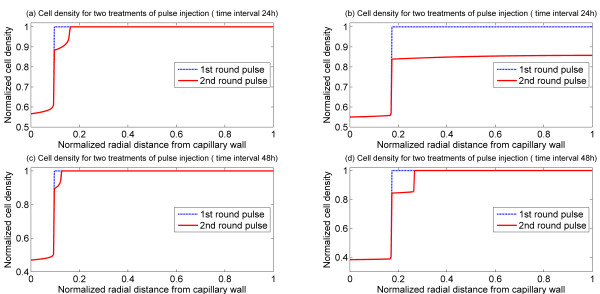
Spatial profiles of cell density for two rounds of pulse injection with the same pulse height and weight, S = 4, T = 1.5 h. Upper panel: cell density at 36 h with 24 h interval between pulses, (a) Bistable switch case, (b) Monostable switch case. Lower panel: cell density at 60 h with 48 h interval between pulses, (c) Bistable switch case, (d) Monostable switch case.